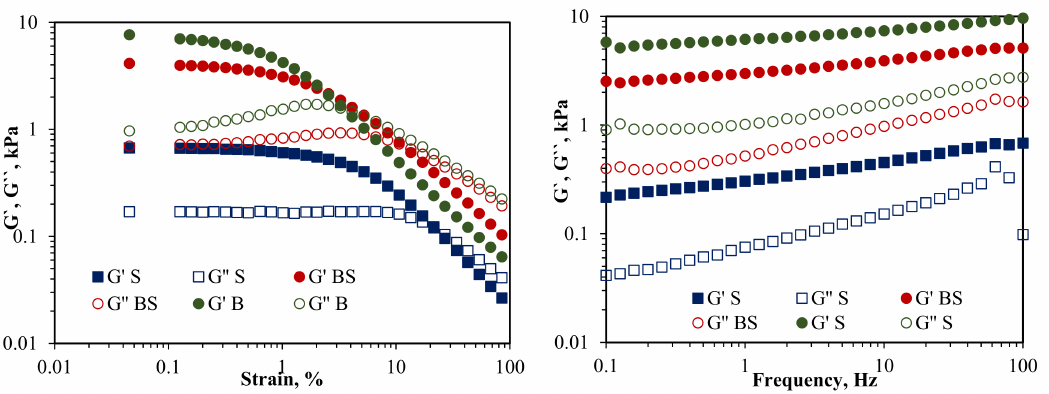
Figure 1. Elastic modulus (G’) and viscous modulus (G”) variation with stain and frequency (B, red beetroot marmalade; S, sour cherry marmalade; BS, red beetroot and sour cherry marmalade).